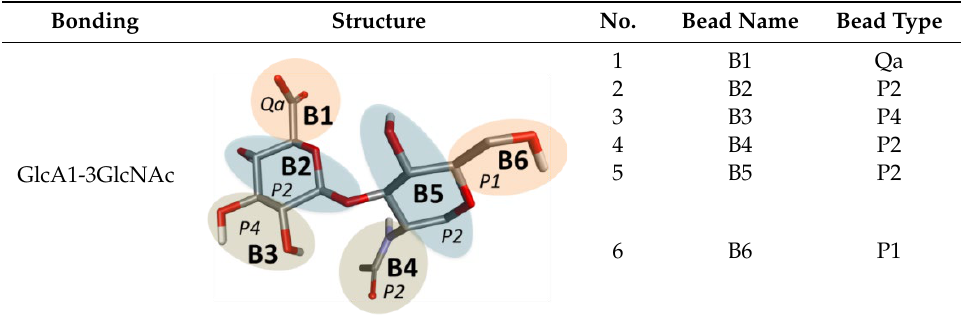
Table 2. Assignment of Martini CG bead types for HA1-4